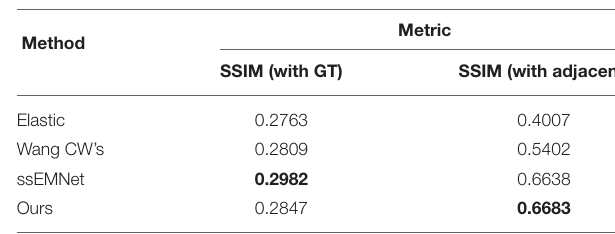
TABLE 2 | Quantitative results comparison of structural similarity index (SSIM) on Drosophila ssTEM (DST)-CREM